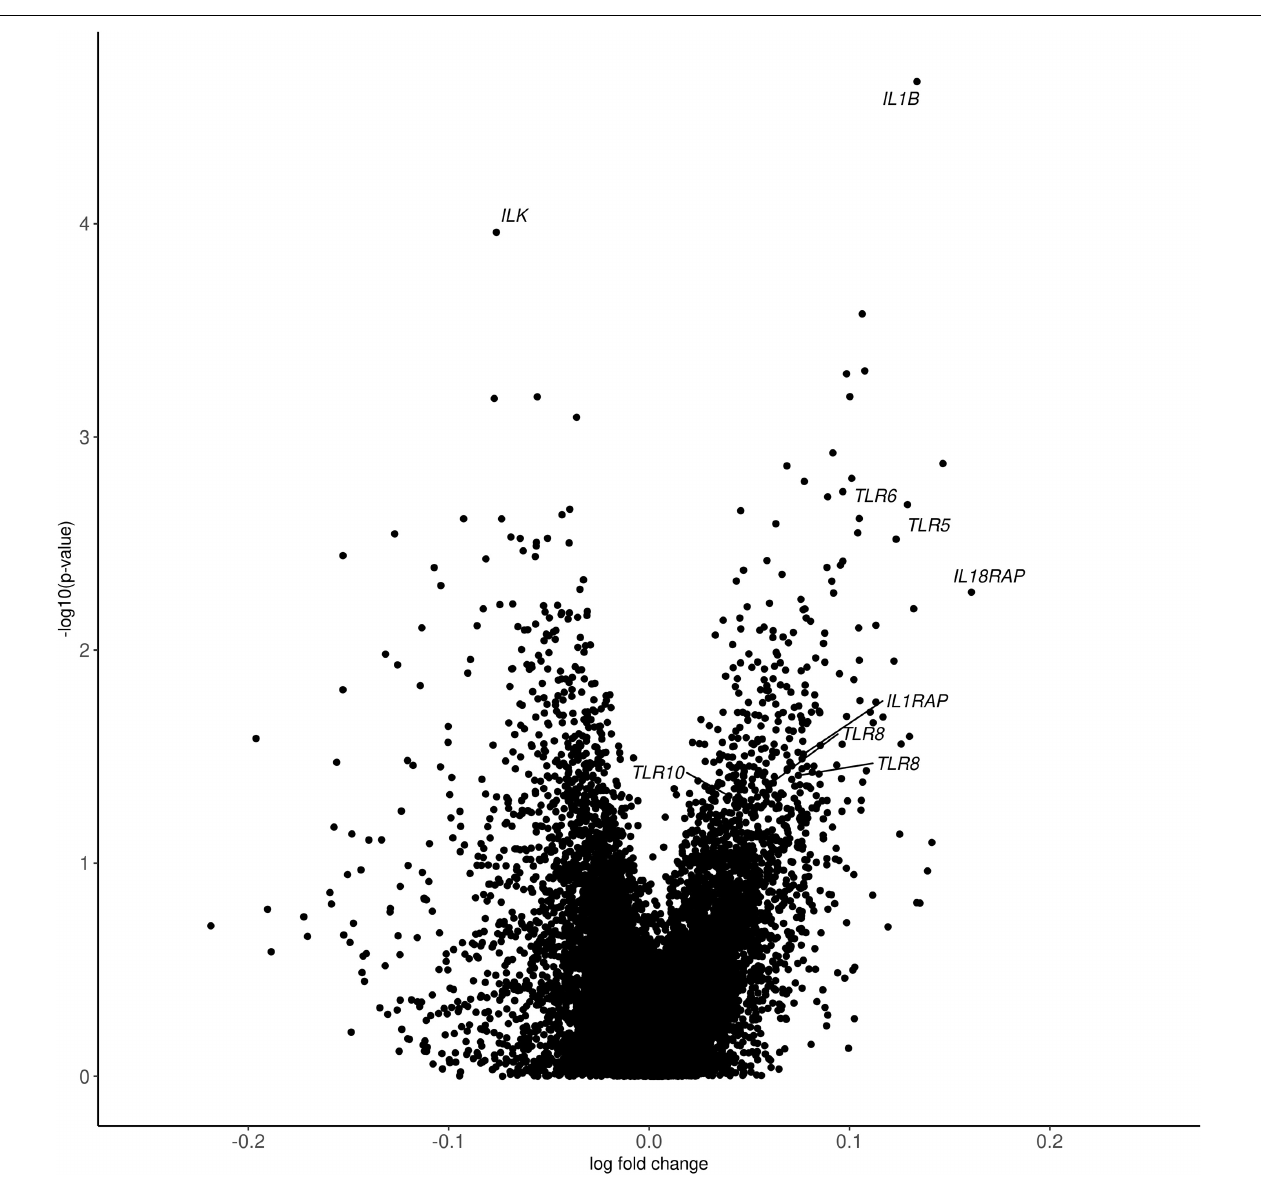
FIGURE 1 | Volcano plot depicting differential gene expression p -values from meta-analysis and log fold change from the MIRECC/Duke cohort. In each cohort, differences in gene expression between PTSD cases and controls were interrogated controlling for age, PCs, sex (except in GMRF-QUT, which was exclusively male), smoking status, and cell proportions. The most significant genes ( IL1B and ILK ) and those from the enriched Toll-interleukin 1 resistance pathway (SM00255:TIR; TLR5 , TLR6 , TLR8 , TLR10 , IL1RAP , and IL18RAP ) are